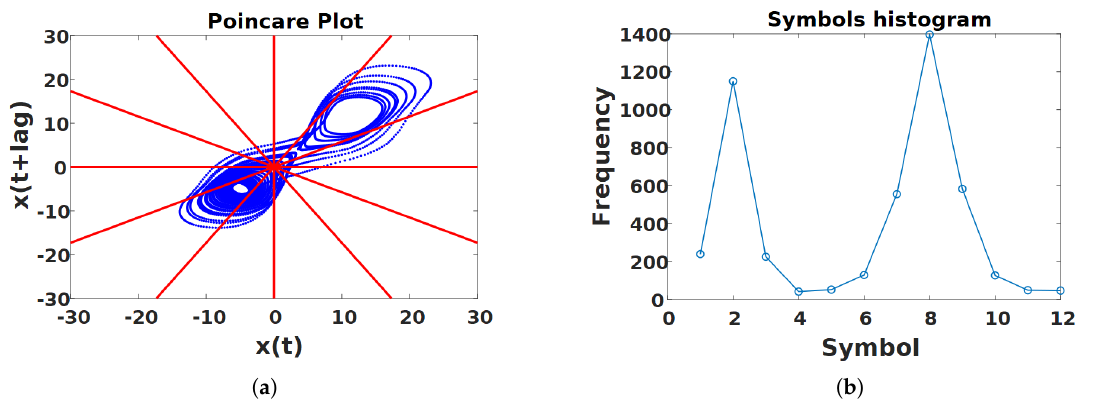
Figure 6. Feature extraction using the symbolic dynamics calculated from the Poincaré plot. ( a ) Poincaré plot from the Lorenz model constructed with the x ( t ) component. The twelve angular regions are overlapped, and a single symbol is assigned to each of points included in the region ( b ) Histogram calculated from the Poincaré plot for the Lorenz model. The histogram represents the set of features useful for fault classification.